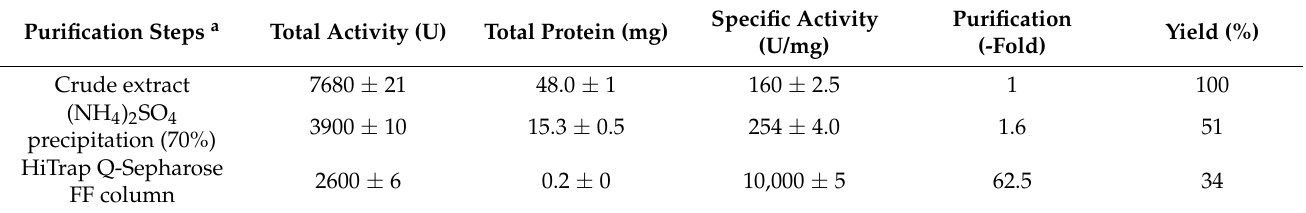
Figure 3. Purification of PCrL. ( A ) Chromatogram profile of PCrL purification on HiTrap ™ Q-Sepharose FF column. Adsorbed proteins were eluted with a linear NaCl gradient of 0 – 200 mM NaCl in buffer A. PCrL activity was measured, as described in Section 4 (§ 4.5), using TC8 as the substrate. ( B ) SDS-PAGE (12% acrylamide) analysis of eluted proteins. Lane 1, molecular mass marker; lane 2, resuspended pellets after ammonium sulfate (70%) precipitation; lane 3, non-retained proteins; lane 4, pooled active fractions from HiTrap™ Q-Sepharose FF column. Table 1. Flow sheet of the PCrL purification steps.